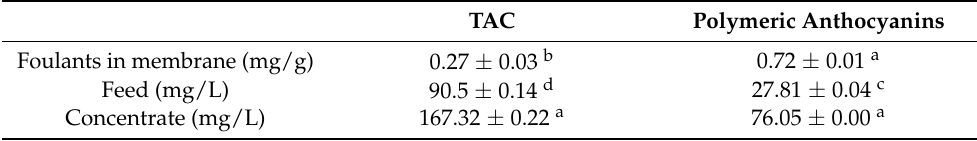
Table 1. Content of anthocyanins in membrane foulants and feed.